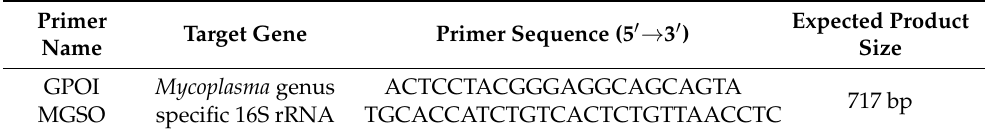
Table 5. Primers used for the detection of